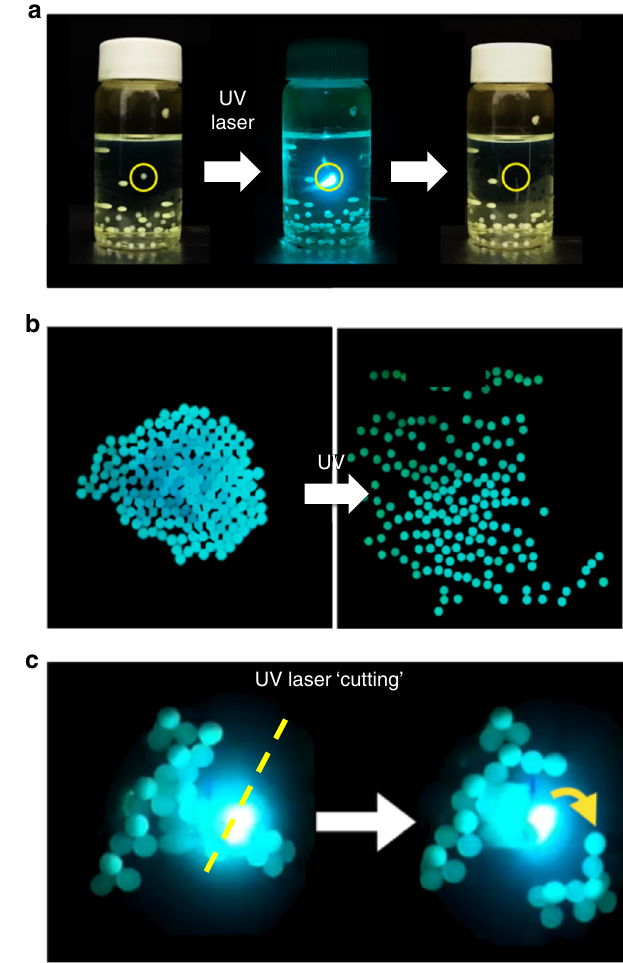
Fig. 5 Spatial control of discharging of tribocharges on polymers by (focused) light. a Polymer beads charged in the dye solutions (shown here, 40 poly(tetra fl uoroethylene) (PTFE) beads in 1 × 10 − 5 M Coumarin 6 (C6) in dry hexane) can be individually discharged by targeting them with a handheld laser (404 nm). b A 1:1 electrostatic self-assembly of PTFE and poly(oxymethylene) (POM) beads 29 in C6 solution (1 × 10 − 5 M, dry hexane) in a gently agitated petri dish can be disassembled after discharging of the beads upon UV illumination. c 2D and 3D assemblies of polymer beads can be “ cut ” by a laser at desired locations. (Here shown, 1:1 electrostatic self-assembly of PTFE and POM beads in C6 solution (1 × 10 − 5 M, dry hexane), see also Supplementary Movie 5) Charge measurement of individual beads in hexane . A homemade Faraday cup built from two concentric brass cylinders (1 cm height, and 1.2cm and 0.8 cm radii) placed inside of the cap of the glass vial was connected to a high precision electrometer, Keithley Instruments, model 6517B. The beads were dropped one-by- one into the Faraday cup by mechanical agitation (Supplementary Figure 4).